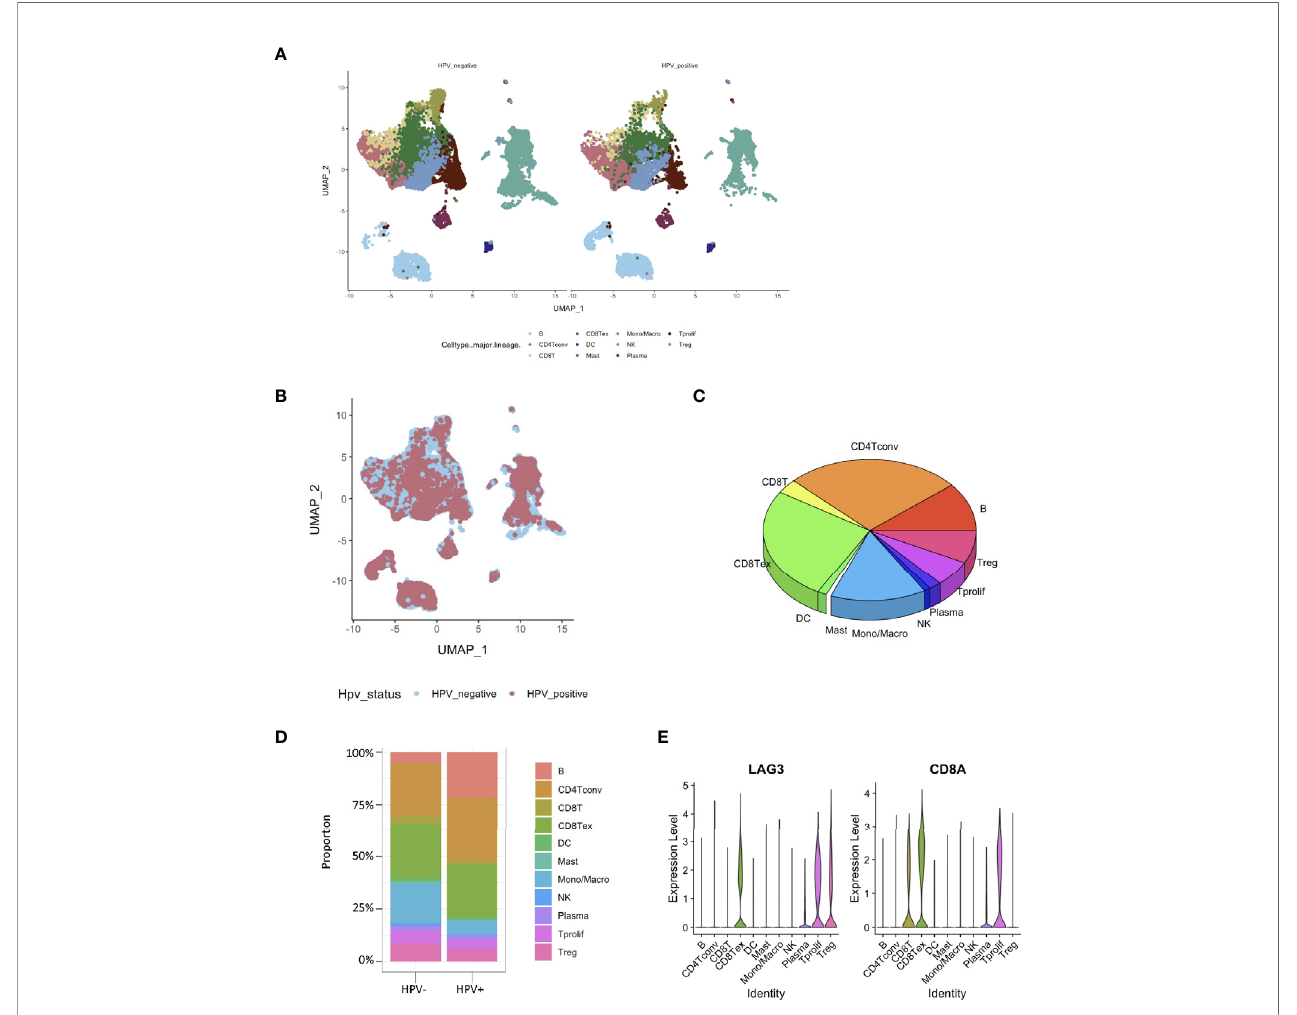
FIGURE 2 | Identi fi cation of HPV − and HPV+ HNSCC tumor-in fi ltration of CD8+ T cell-correlated genes. (A) View of single cell samples from HPV − and HPV+ TIL. The annotated UMAP plot identifying 11 distinctive cell types. (B) The annotated UMAP plot of HPV − and HPV+ HNSCC TIL. (C) A pie chart of the seven cell types that make up the TIL of HNSCC. (D) Bar graphs of the cell proportions in the TIL of HPV − and HPV+ HNSCC. (E) Violin plots illustrating the expression of CD8A and exhausting T cell marker LAG3 in different TIL cell